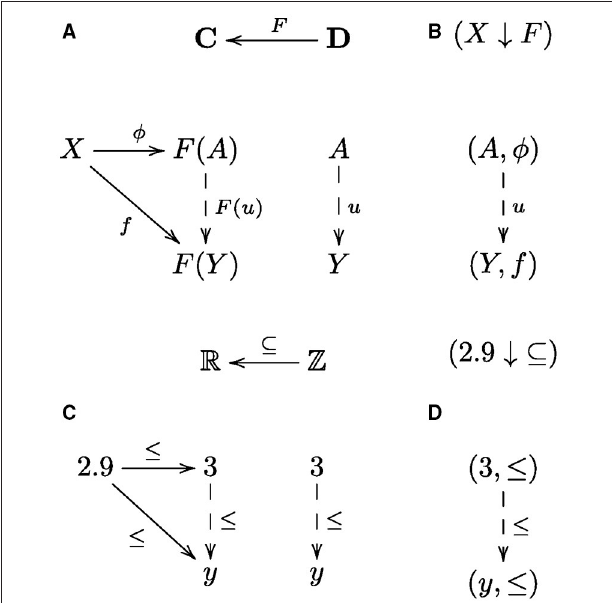
FIGURE 2 | Universal construction and comma category. The diagram in (A) shows the general form of a universal arrow, which is the pair ( A ,φ ), from an object X in a category C to a functor F : D → C from a category D to C . To be a universal arrow, as such, for every object Y in D and every arrow f : X → F ( Y ) in C there must exist a unique arrow u : A → Y , in D , such that f = F ( u ) ◦ φ . The diagram in (B) shows the corresponding comma category, denoted ( X ↓ F ), whose objects are the pairs ( Y , f ) and arrows are the arrows u that uniquely satsify the “triangle” equation, f = F ( u ) ◦ φ . The collection of objects in the comma category includes the universal arrow, ( A ,φ ), because for Y set to A and f set to φ the triangle equation is uniquely satisfied by setting u to the identity arrow 1 A . The universal arrow is the initial object in the comma category, which is straightforward to prove. Dashed lines indicate that the arrows are unique. An example universal construction (C) and corresponding comma category (D) is the universal arrow from the object (real number) 2.9 to the inclusion functor (function) from the integers to the real numbers (regarded as posets with the usual order ≤ , hence categories) is the pair (3 , ≤ ). The number 3 corresponds to the smallest integer greater than or equal to 2.9. In general, for a real number x ∈ R , the object component of the universal arrow ( a , ≤ ) from x to the inclusion function/functor is obtained by rounding up to the nearest integer a ∈ Z greater than or equal to x , i.e., obtained by the ceiling function, a = ⌈ x ⌉ , and the corresponding comma category consists of all the integers y greater than or equal to a , i.e., the set { y ∈ Z |⌈ x ⌉ ≤ y }